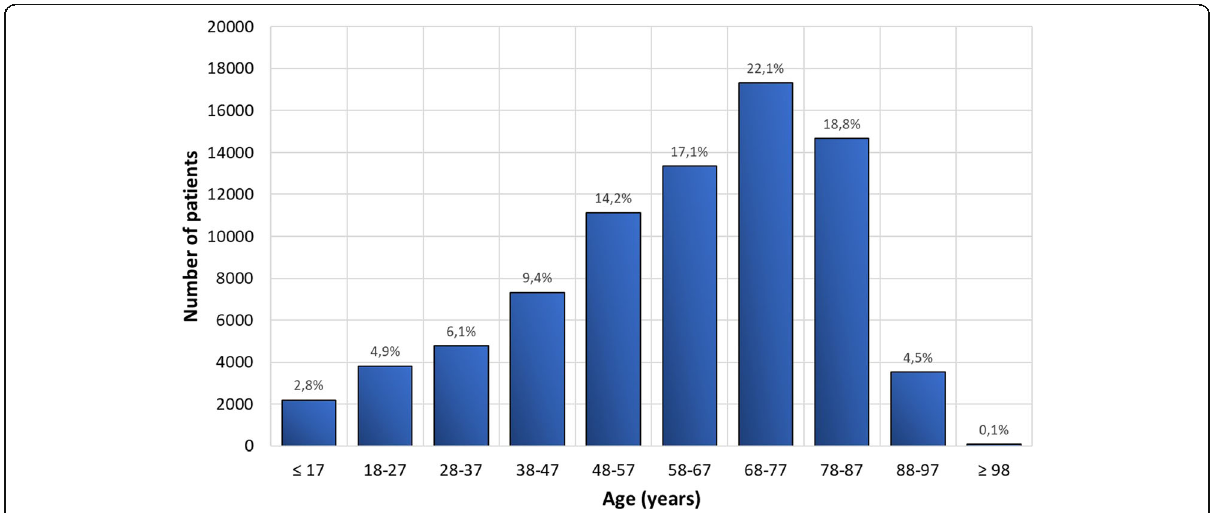
Fig. 2 Age distribution of patients who had computed tomography in